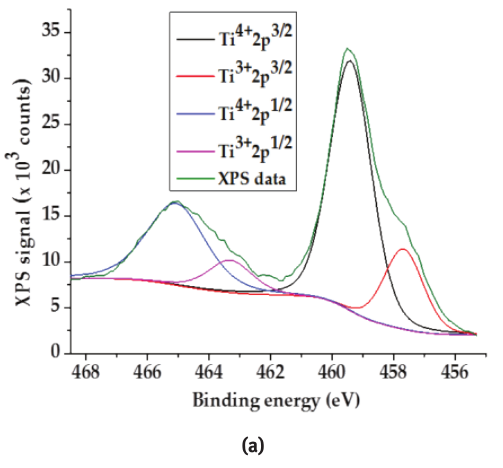
Figure 1: XPS spectras (a) Ti 2p (b) O 1s of as-deposited d-TiO